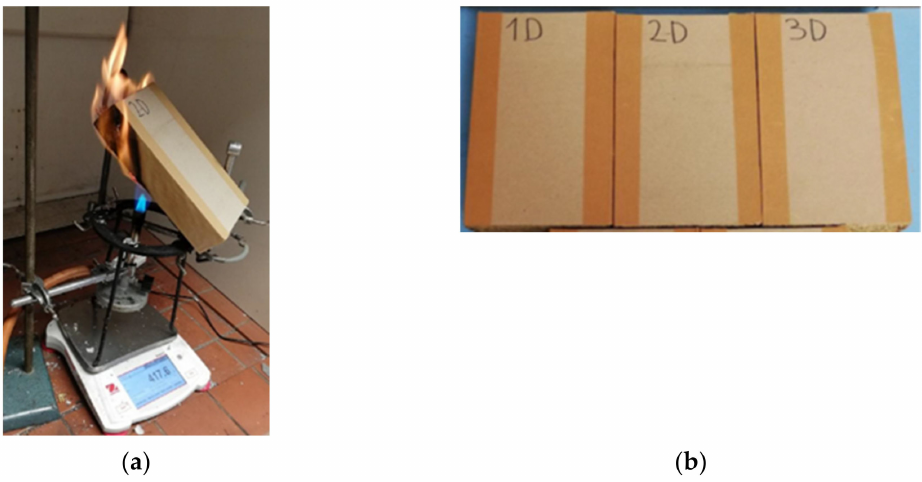
Figure 4. ( a ) Treatment of the experiment for group D samples. ( b ) Samples